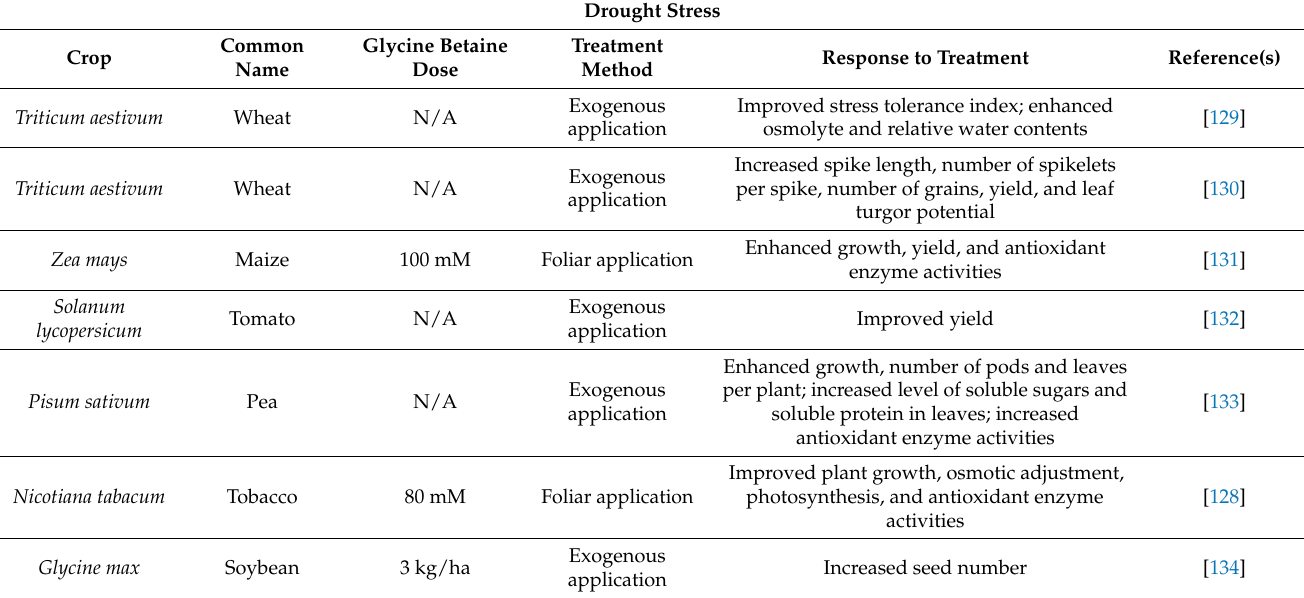
Table 16. Physiological responses of various crops to glycine betaine treatment against drought stress. Drought